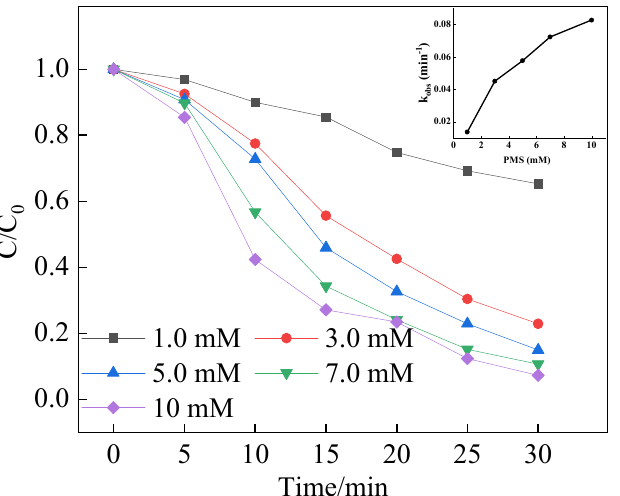
Figure 6. Effect of PMS concentration on BPA removal. Conditions: C 0 = 0.05 mM, [LCFO-4] = 0.7 g/L, pH 0 6.8.